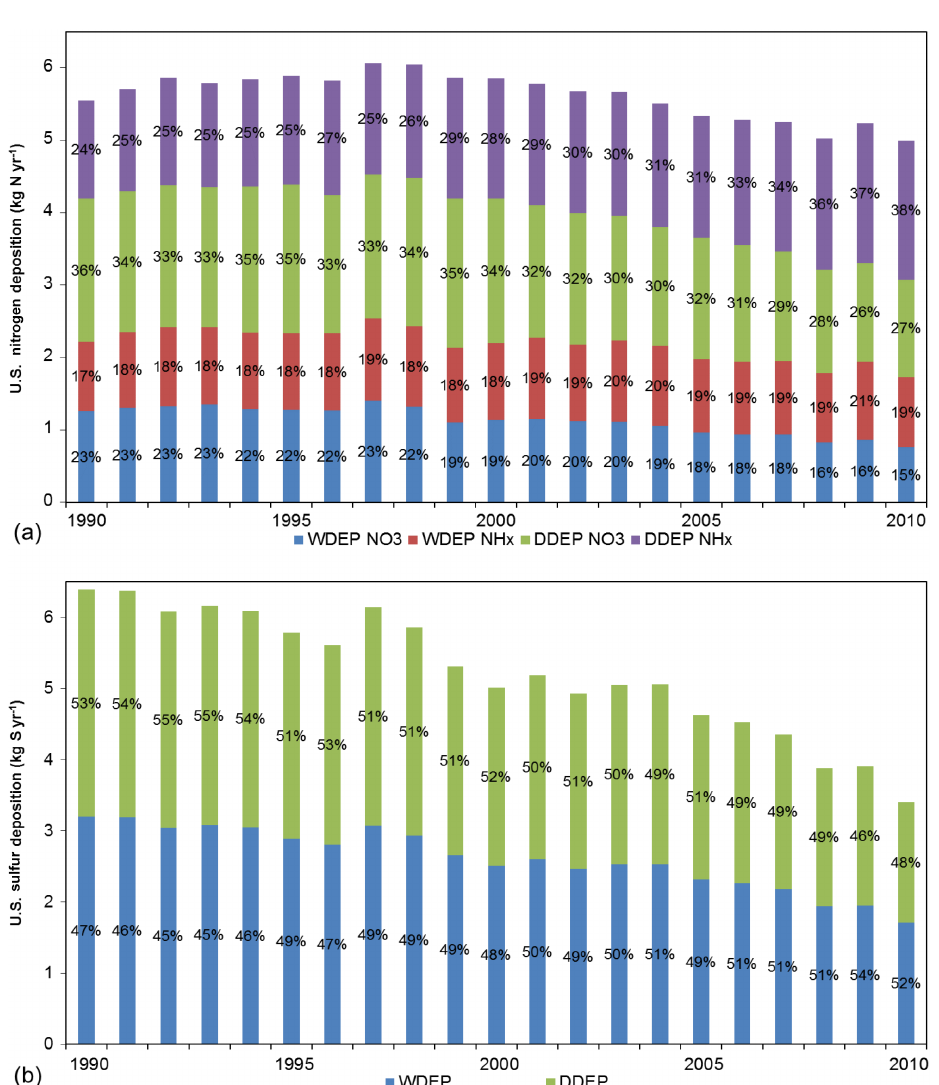
Figure 8. Interannual variability of the TDEP for inorganic nitrogen (a) and sulfur (b) in the US from 1990 to 2010, including their fractions labeled as percent contributions for WDEP of oxidized nitrogen (NO 3 ), WDEP of reduced nitrogen (NH x ), DDEP of oxidized